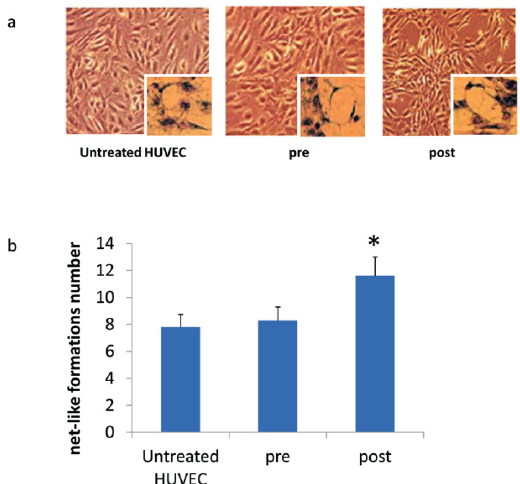
Figure 5. ( a ) Net-like formations originated from HUVECs co-cultured with hMSCs without (no sera added to the medium; untreated HUVEC) or with sera collected from patients before (pre) and after three months of DOAC treatment (post). Magnification 10×; insert magnification 40×; ( b ) the graph shows the net-like formations number calculated on the above